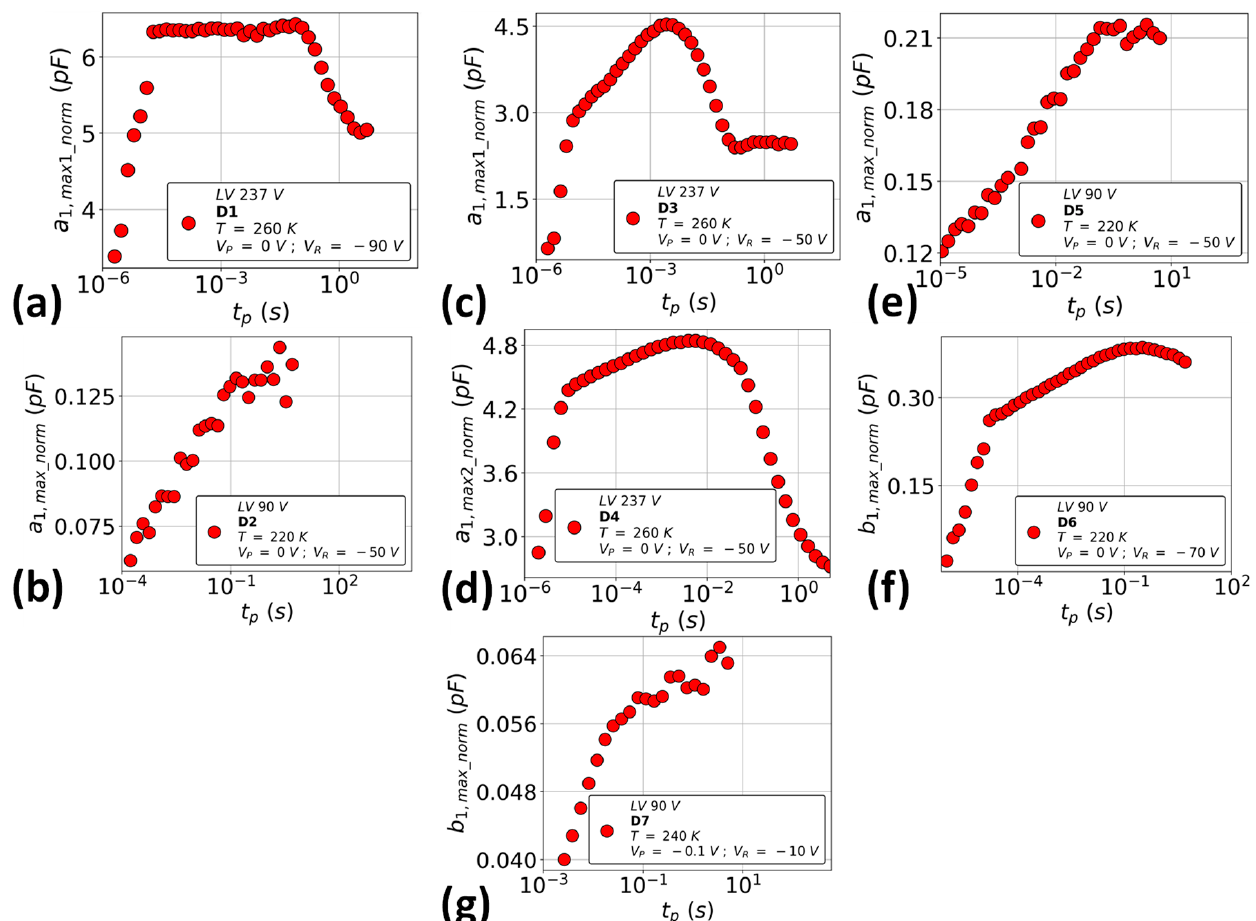
Figure 5. DLTFS normalized peak amplitude versus the filling pulse width: t p for the trap levels observed in both samples ( a ) D1; ( b ) D2; ( c ) D3; ( d ) D4; ( e ) D5; ( f ) D6; ( g ) D7. Note: Some signals are not available for the entire t P range because the peaks were out of the measured range or were too small. The signature of every trap group as a function of the filling pulse time (t P ) is shown in Figure 5. The signatures were represented independently of the chosen coefficient (b1 or